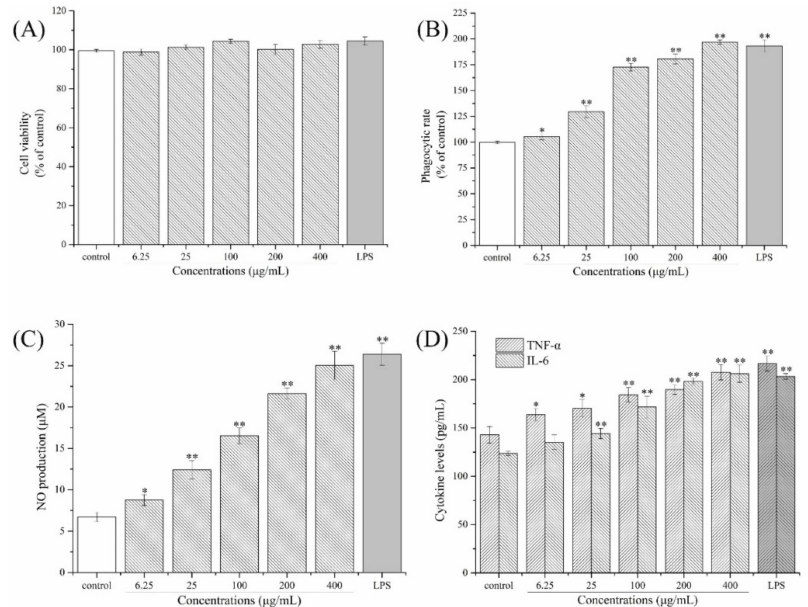
Figure 6. Immunoregulatory effects of the CPPs on Raw264.7 macrophages (( A ) cytotoxic evaluation, ( B ) phagocytic rates, ( C ) NO production, ( D ) TNF- α and IL-6 cytokines secretion). Significant differences are designated as * p < 0.05 and ** p < 0.01, compared with the control